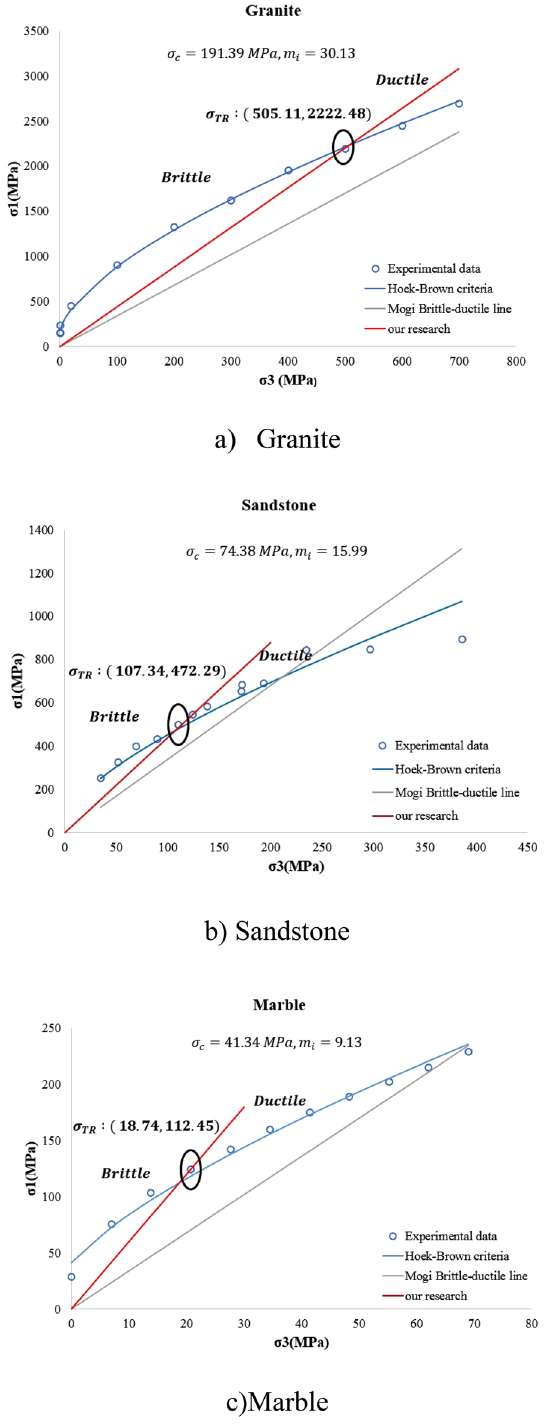
Figure 9. Brittle-ductile transition stress based on Eqs. (7) and (8) for ( a) Granite, ( b ) Sandstone, and ( c ) transition stress, and experimental data for granite, sandstone, and marble (see Table A.4). For granite, with UCS = 191.39 MPa and m i = 30.13, the brittle region is between 0 and σ 3 =505 MPa, the ductile region occurs at σ 3 > 505.11, and the brittle-ductile region occurs at σ TR = 505.11 MPa. For sandstone, with UCS = 74.38 MPa and m i = 15.99, the brittle region is between 0 and σ 3 =107.34 MPa, the ductile region occurs at σ 3 > 107.34, and the brittle-ductile region occurs at σ TR = 107.34 MPa. For marble, with UCS = 41.34 MPa and m i = 9.13, the brittle